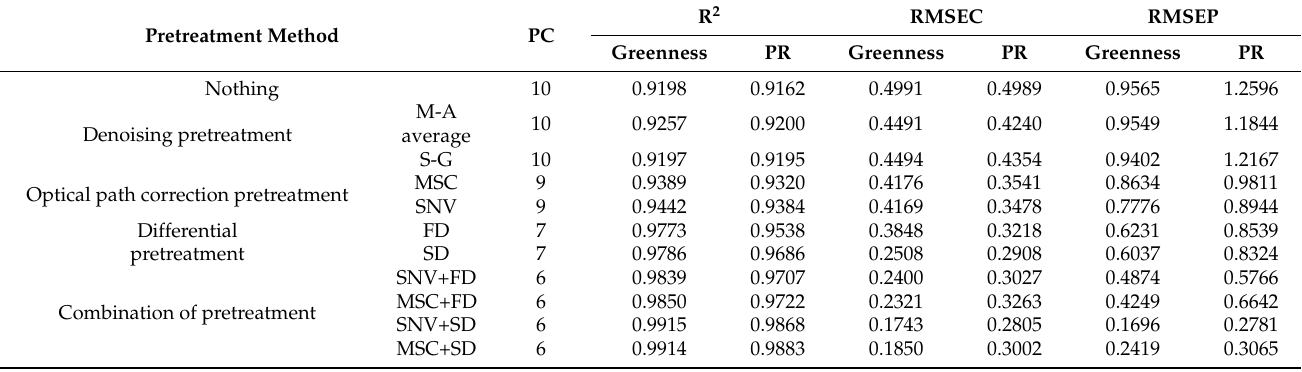
Table 1. Statistics of the data preprocessing methods for the number of principal components (PCs), greenness value (a), and photosynthetic rate (PR) of tomato leaves based on the fluorescence